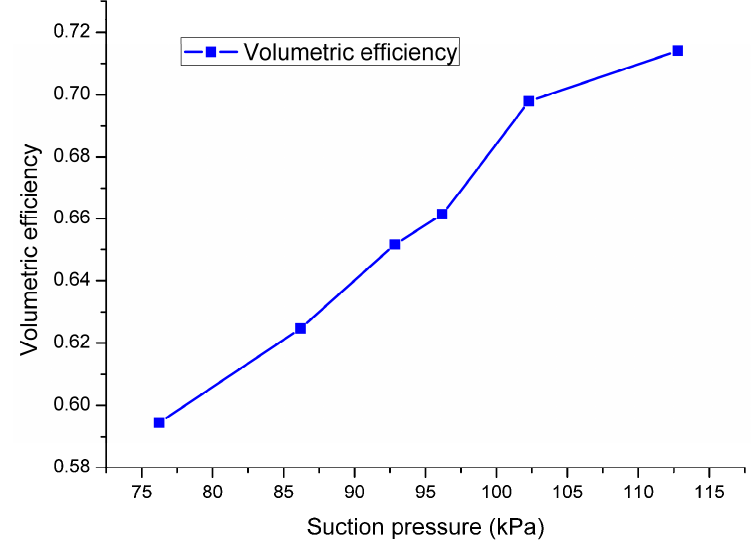
Figure 7. Volumetric efficiencies and suction time under different suction pressures